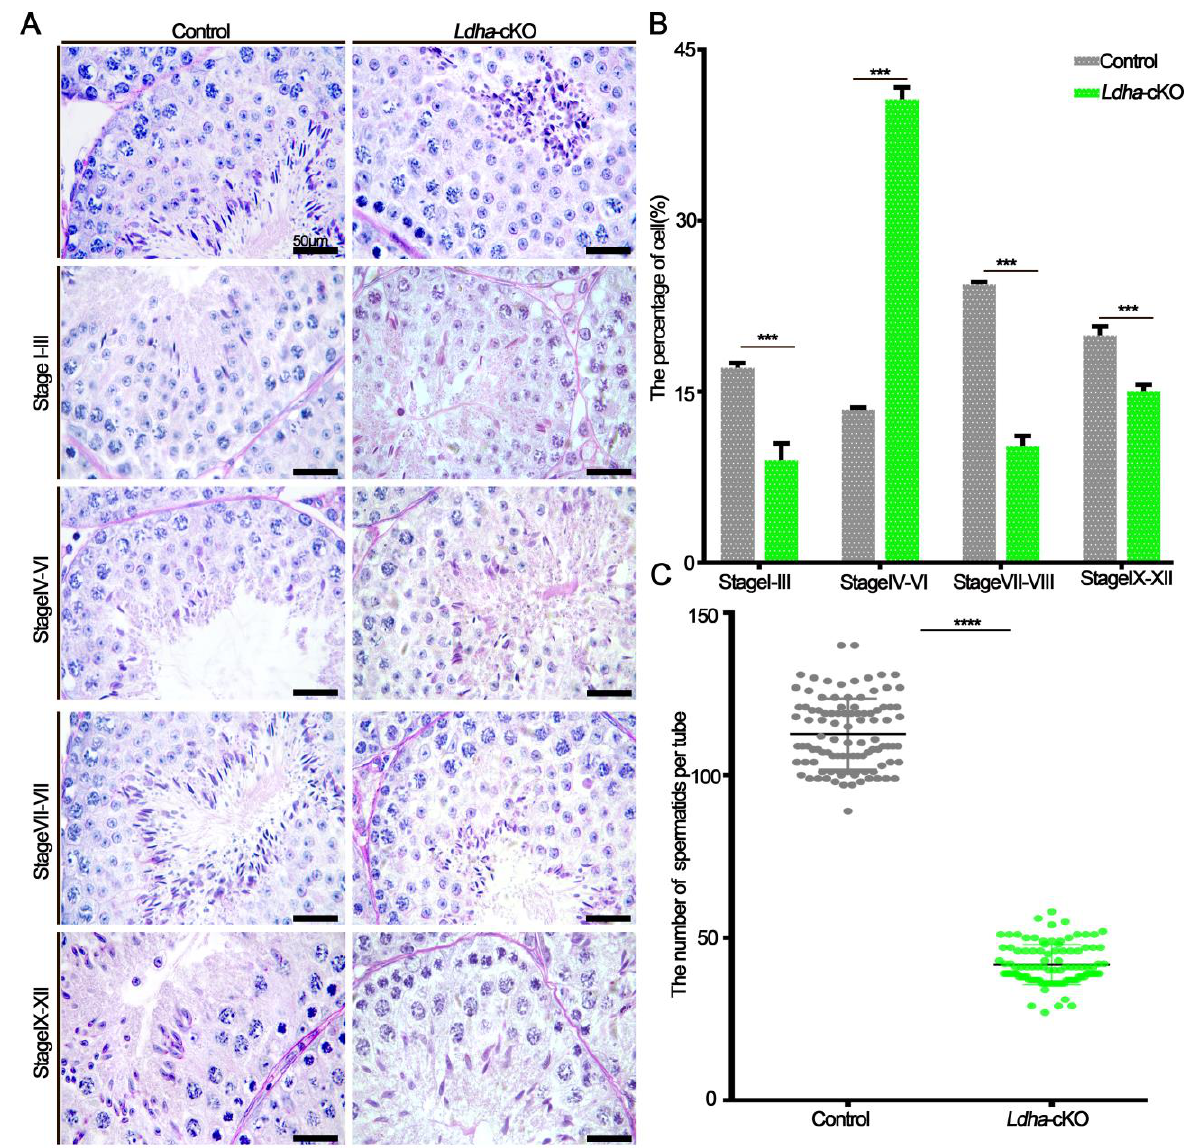
Figure 3. Ldha deletion in Sertoli cells altered the spermatogenesis stage. ( A ) Representative images of periodic acid–Schiff (PAS)-stained testes from the three-month-old control and Ldha -cKO mice (scale bar = 50 µ m). ( B ) Distribution of stages in the PAS-stained tests from the male control and Ldha -cKO mice at the age of three months (scale bar = 50 µ m). At least 1000 tubes were counted per group. *** indicates a significant difference of p < 0.001. ( C ) Round spermatids were counted in stages VII – VIII of Seminiferous tubules in the male control and Ldha -cKO mouse testes. (n = 5). At least 200 tubes of stages VII – VIII of Seminiferous tubules were counted per group. **** indicates a significant difference of p < 0.0001.